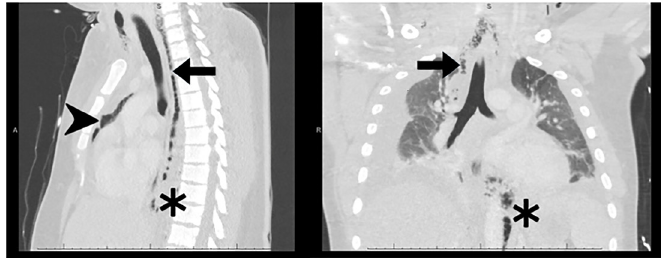
Image 3. Computed tomography of the chest with intravenous contrast in coronal (right) and sagittal (left) planes, demonstrating mediastinal air and fluid tracking from the retropharyngeal space (arrows), extensive pneumo-mediastinum (arrowhead), and retrocrural subcutaneous gas